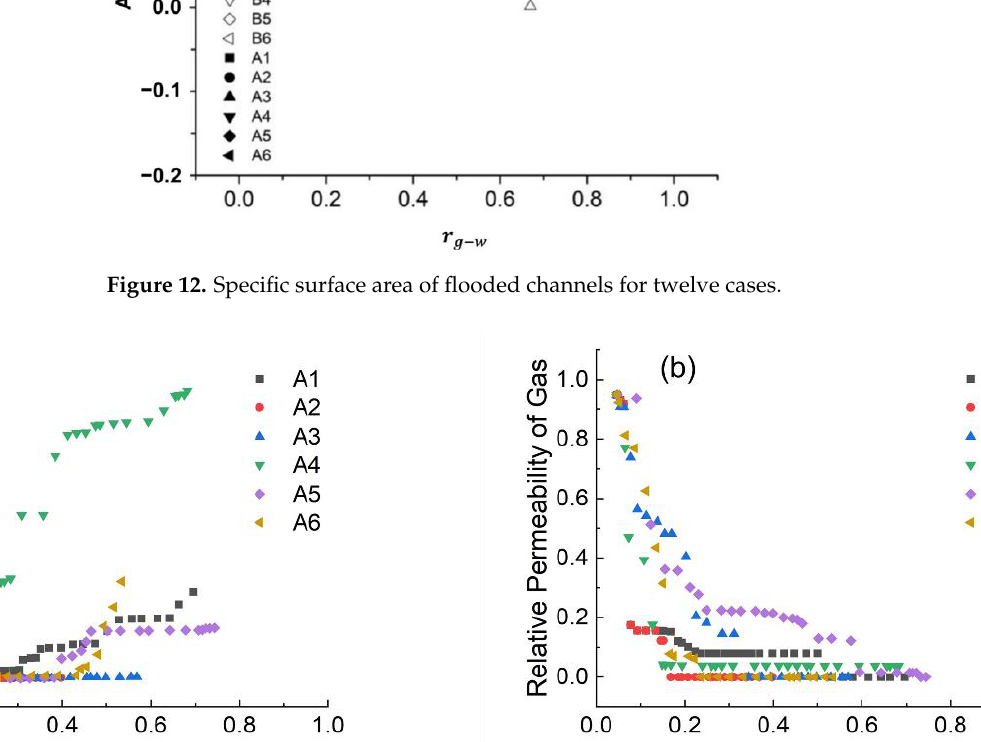
Figure 13. The effect of wettability heterogeneity on the relative permeability curve. Simulation results are plotted as scatter points representing the water relative permeability ( a ) and gas relative permeability ( b ), respectively.